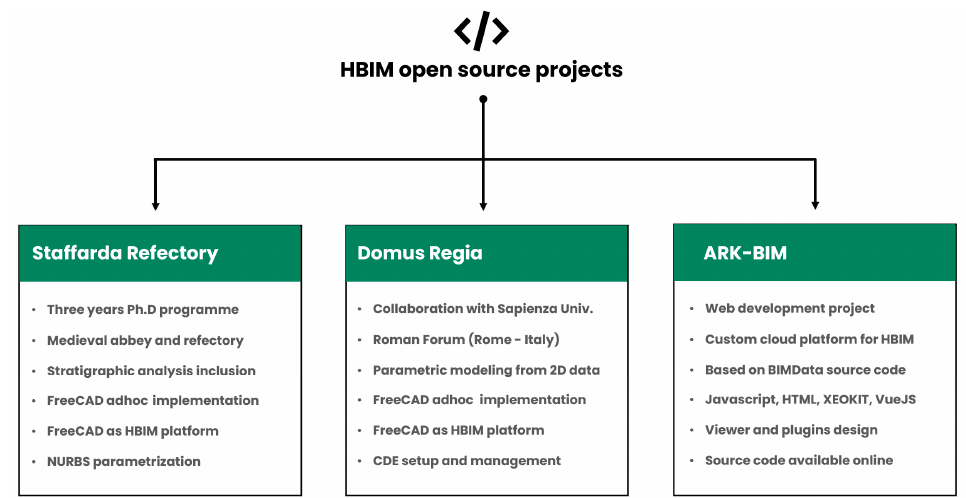
Figure 1. HBIM projects designed and developed via open source instruments and programming languages: the Staffarda refectory project, the Domus Regia project and the ARK-BIM development.